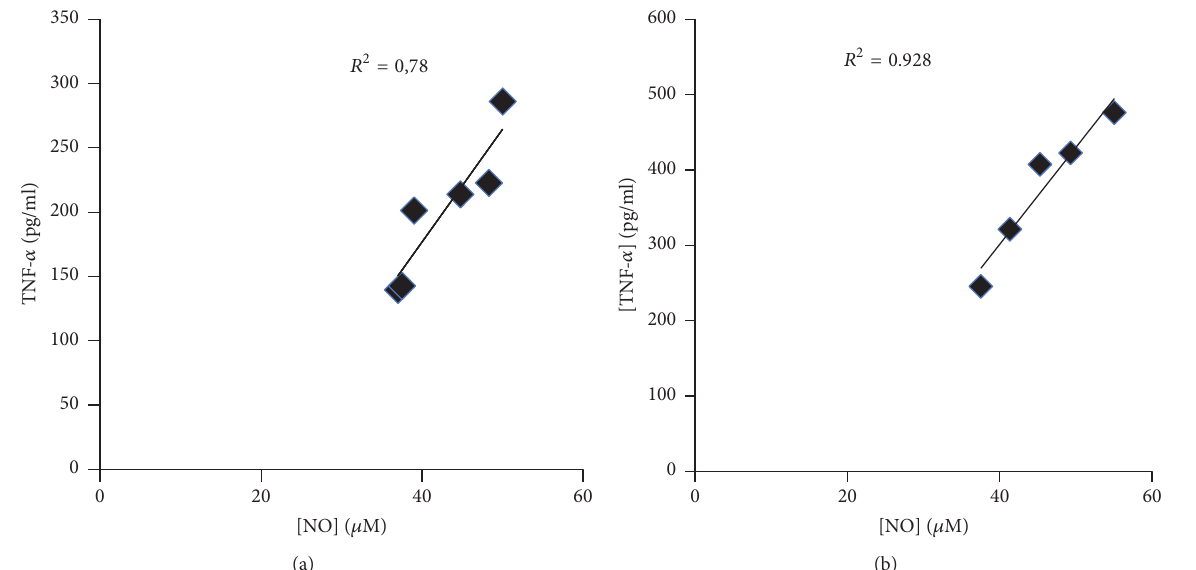
Figure 1: Correlation between the serum NO levels and the serum TNF- 𝛼 levels in Algerian patients with (a) active UC and (b) CAC. (a) There is a significant correlation between NO levels and TNF- 𝛼 levels in patients with active UC ( 𝑅 2 = 0.78 ). (b) There is a significant correlation between the NO levels and TNF- 𝛼 ( 𝑅 2 = 0.92 ) levels in patients with CAC (TNF- 𝛼 , tumor necrosis factor-alpha; NO, nitric oxide; UC, ulcerative colitis; CAC, colitis associated cancer).